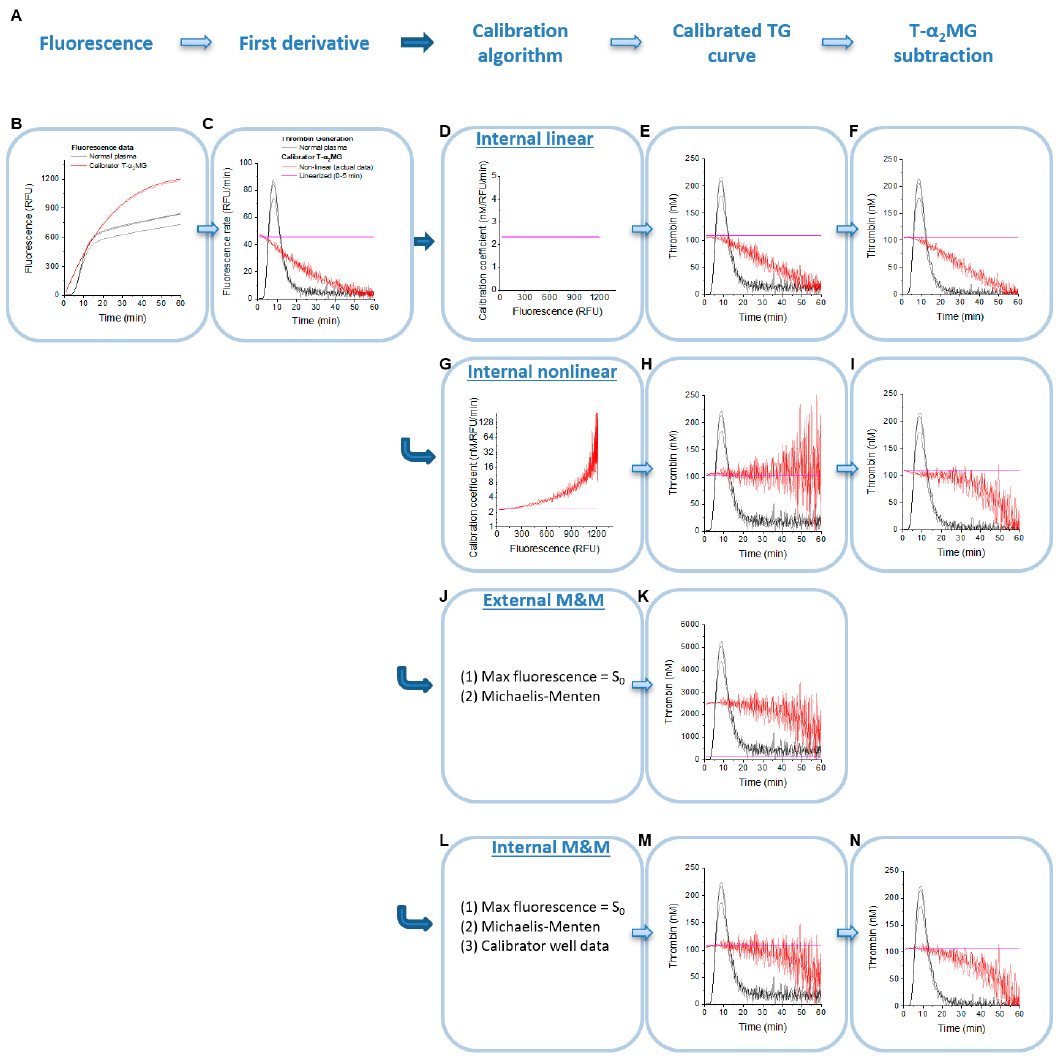
Figure 1. Application of calibration algorithms and thrombin- α 2macroglobulin (T- α 2mg) correction to fluorescence data from thrombin calibrator (red lines) and normal pooled platelet free plasma (PFP, gray lines) triggered with 1 pM TF. This experiment was performed on the CAT instrument and triggered with PPP low reagent. ( A ) The sequence of data analysis procedures as applied by the in-house software. ( B ) Raw fluorescence time-course data for pooled PFP samples and thrombin calibrator (n = 3 replicates each). ( C ) First derivative of fluorescence time course (rate calibration of substrate consumption rate). ( D , G , J , L ): Calibration approaches applied to data in (C): ( D ) Internal linear calibration approach for relative fluorescence units (RFU) per minute into nM of thrombin (calibration coe ffi cient for conversion is the same regardless of the fluorescence level), ( G ) internal nonlinear calibration (takes into consideration the non-linearity of calibration coe ffi cient as derived from the thrombin calibrator curve), ( J ) external Michaelis–Menten (M&M) formula (traditional approach based on previously established k cat and K m ), and ( L ) internal M&M (where v max is calculated from the respective calibrator wells). ( E , H , K , M ): TG curves obtained by the indicated calibration of the first derivative curves in ( C ). ( F , I , N ): TG curves after T- α 2mg subtraction correction. Note: external M&M with T- α 2mg subtraction was not calculated because this method failed to recover expected calibrator